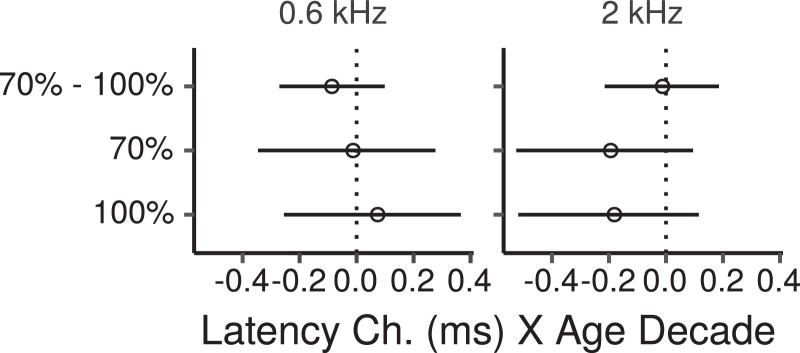
Posterior medians (circles) and 99% credibility intervals for the main effects (across montages) of age on FFR ENV latency estimated by the Bayesian multiple regression model. The top row shows the effect difference between the 70% and 100% MD. Effects are plotted as a latency change, in ms, for an age increase of 10 years.